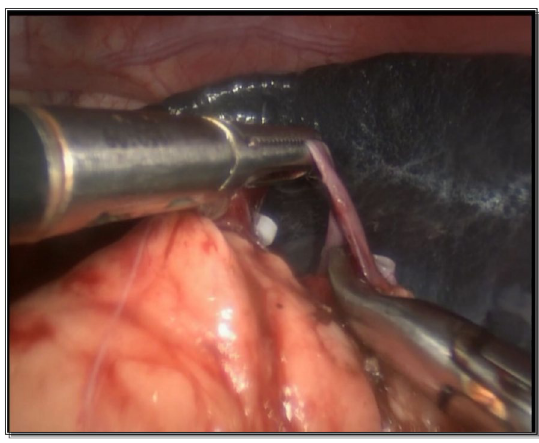
Fig. 5 Selective dissection of the vein